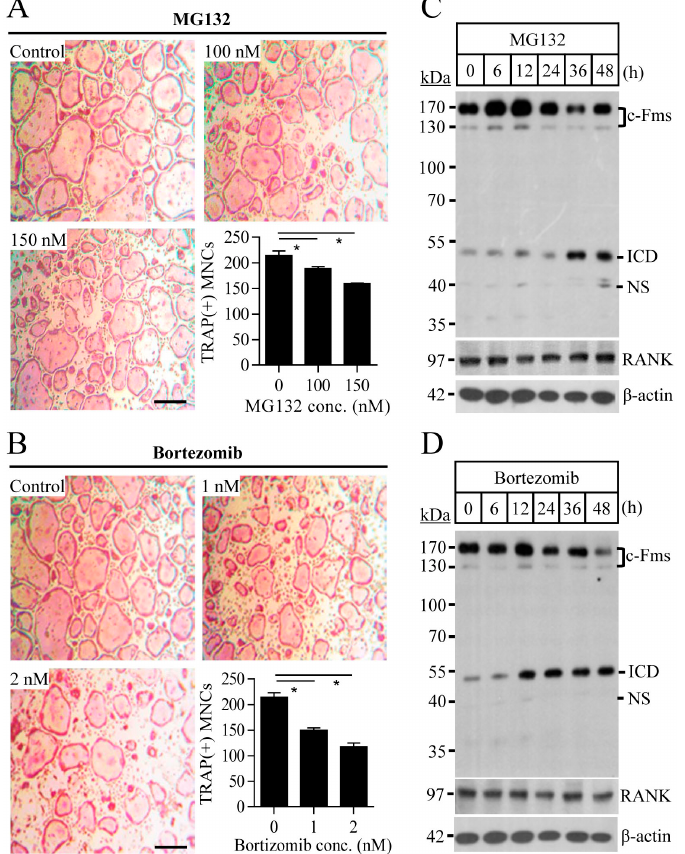
Figure 1. Proteasome inhibitors suppress osteoclast formation and downregulate macrophage colony-stimulating factor (M-CSF) receptor c-Fms. Osteoclast progenitors were cultured with the indicated concentrations of MG132 ( A ) or bortezomib ( B ) in the presence of M-CSF (30 ng/mL) and nuclear factor kappa-B ligand (RANKL) (100 ng/mL) for four days. Tartrate-resistant acid phosphatase (TRAP)-positive multinucleated cells with more than 10 nuclei were counted. Scale bar, 500 µ m. For the immunoblot analysis, cells were treated with 150 nM of MG132 ( C ) or 2 nM of bortezomib ( D ). Intracellular domain (ICD) indicates an intracellular domain of c-Fms (~55 kDa) released by intramembrane cleavage, and NS indicates nonspecific bands. Data are representative of three independent experiments. * p < 0.01.